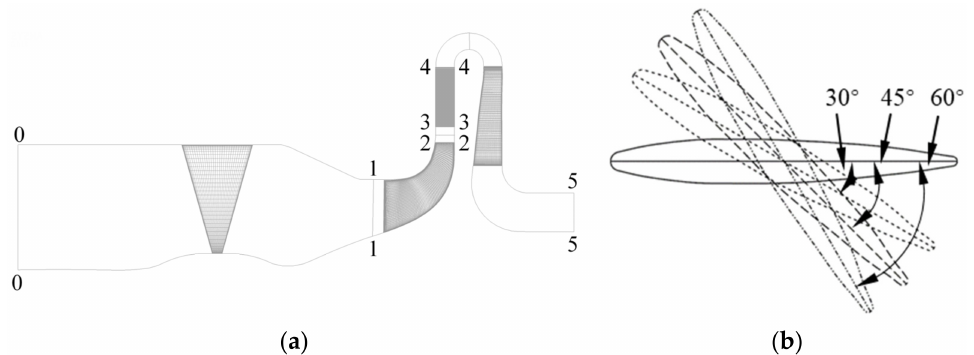
Figure 1. Centrifugal compressor stage: ( a ) meridional view; ( b ) four different guide vane deflection